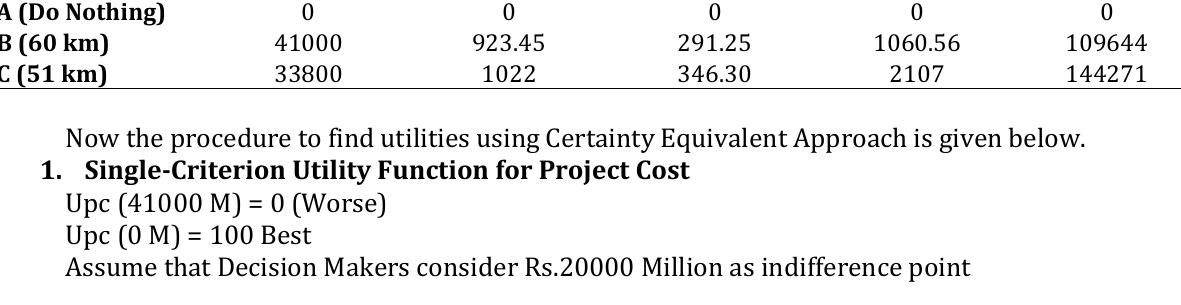
Criteria Level as Per Alternative